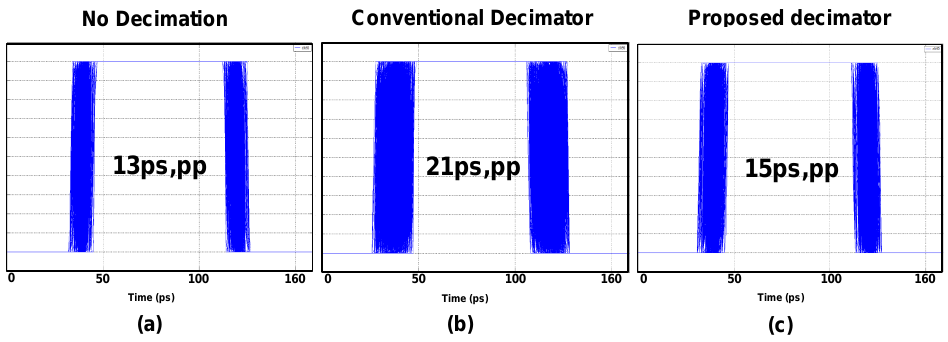
Figure 10. Behavioral simulation results at 10 Gbps for comparing the quality of the recovered clock according to the decimator design: ( a ) no decimation; ( b ) the conventional design; ( c ) the proposed